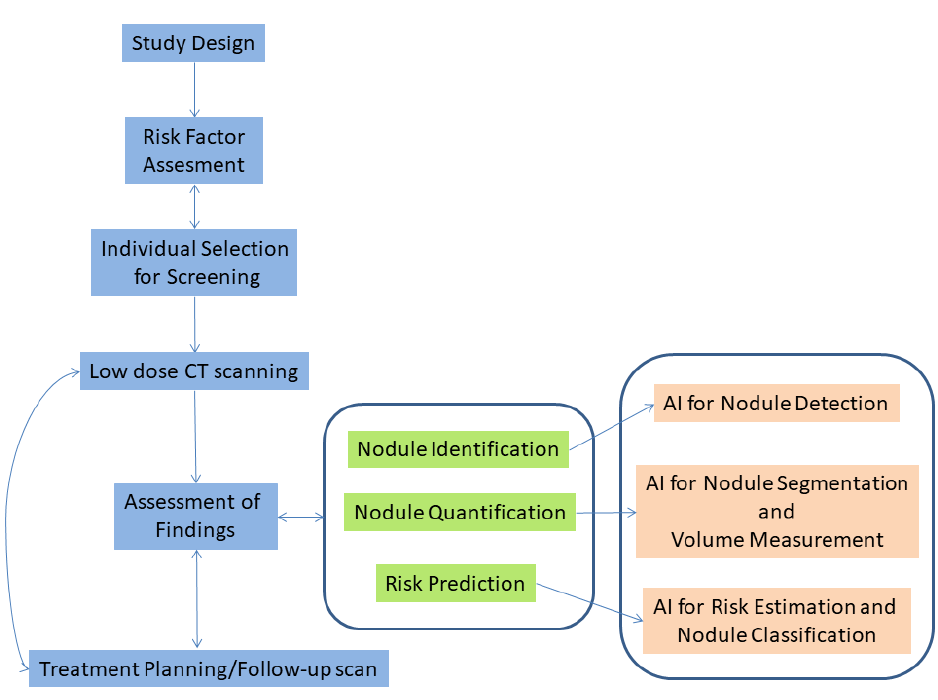
Figure 1. Lung cancer screening workflow along with potential uses of AI software aiming to assist